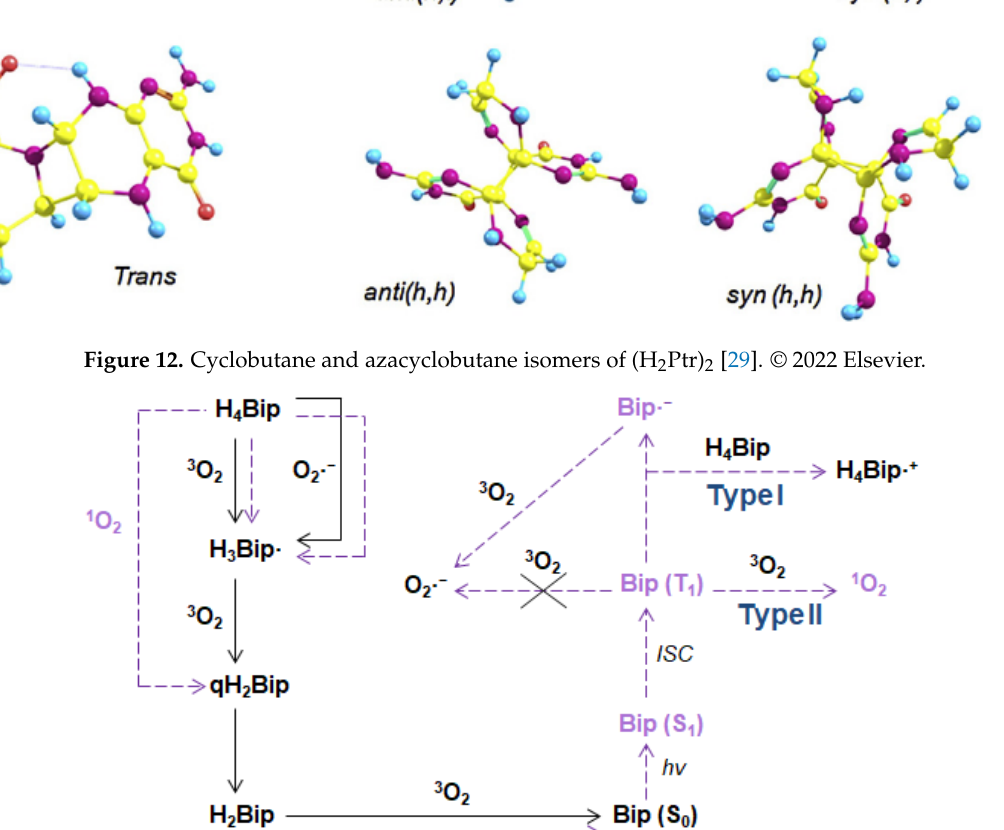
Int. J. Mol. Sci. 2022 , 23 , 15222 20 of 51